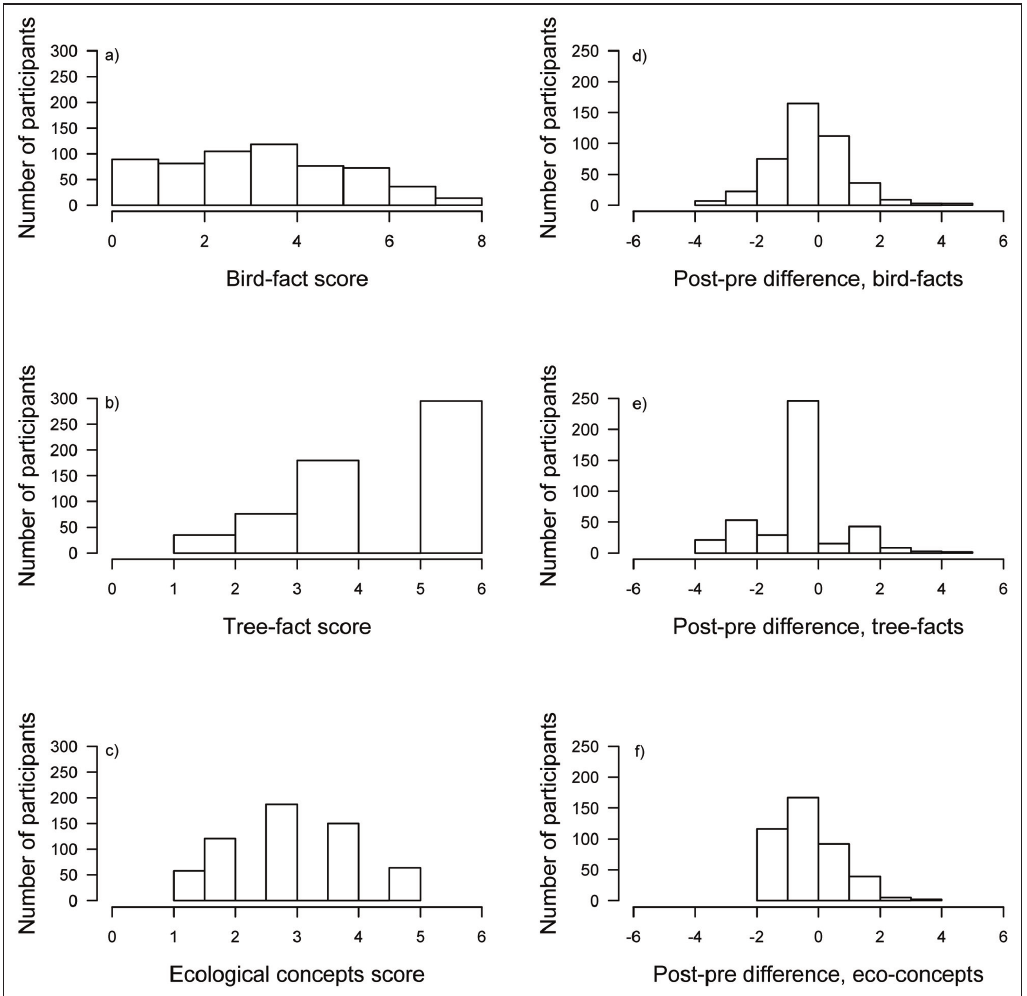
Figure 4: Distributions of pre-test scores (a–c) and post-pre differences in scores (d–f) for the three types of questions. Table 4: Pre-test bias among ~560 participants completing the pre-test. Results of GLMs (for Bird-ID and ecologi- cal concepts) and non-parametric analyses for Tree-ID to determine whether pre-test scores were random with respect to treatment. Sample included all participants who completed the pre-test within 50 minutes, including those who did not take the